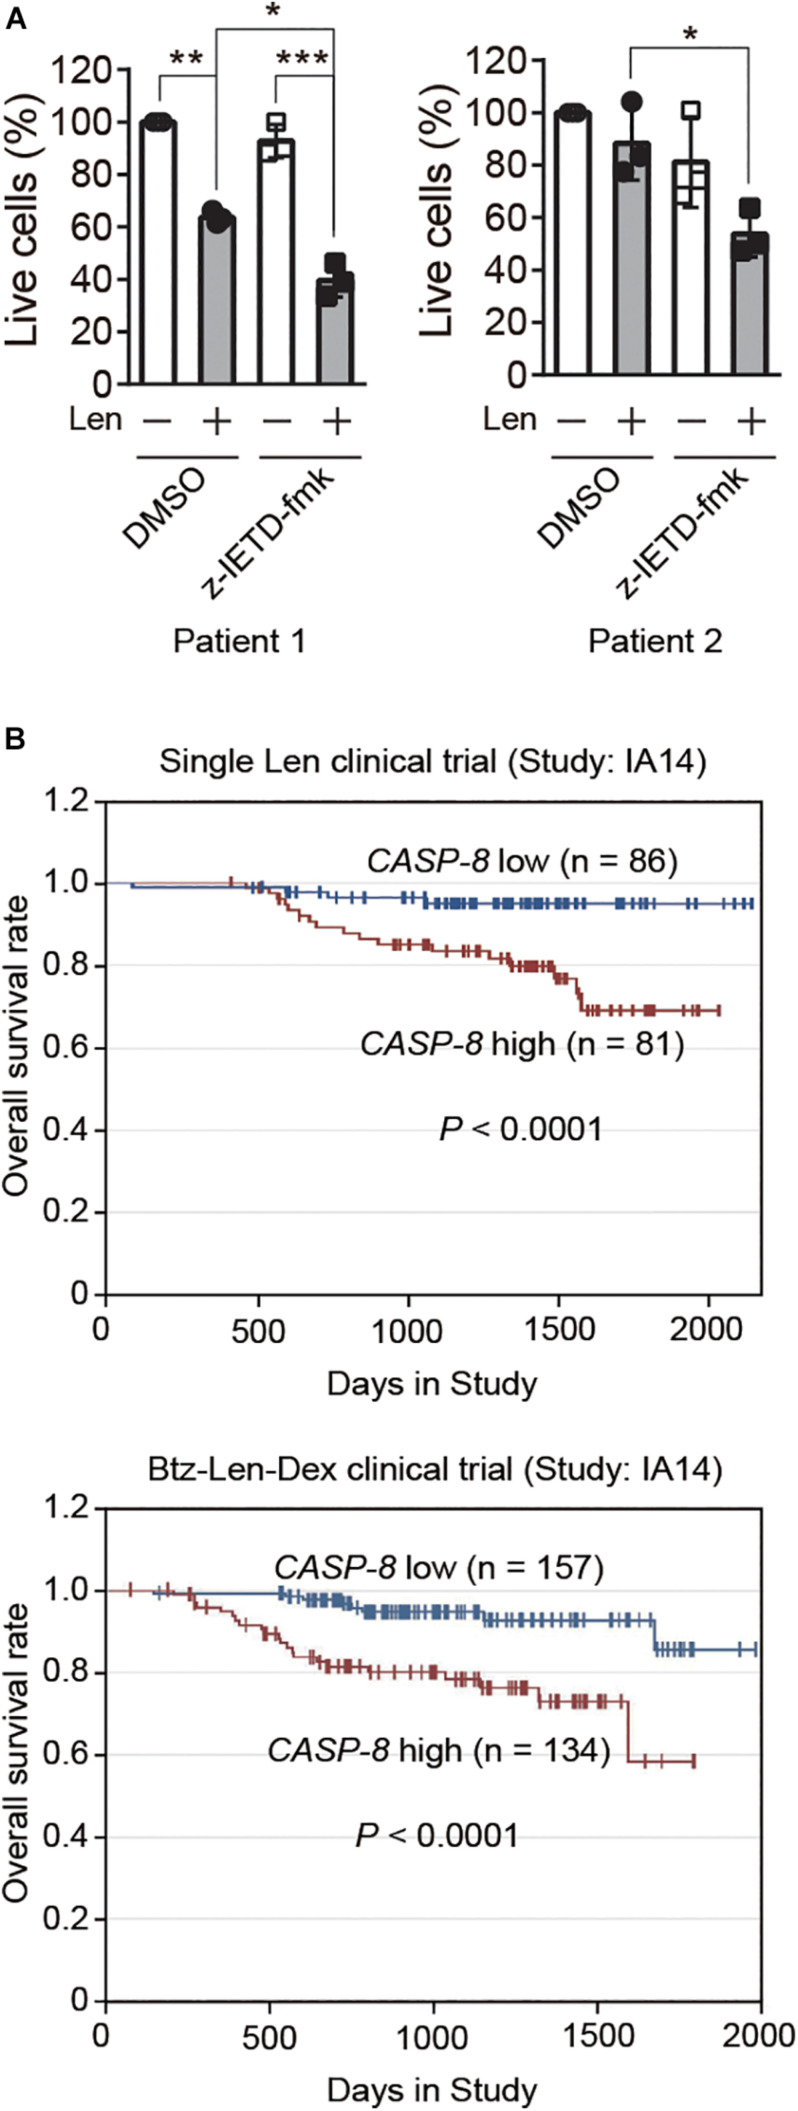
CASP-8 inhibition enhances the anti-myeloma activity of Len in primary myeloma cells, and low CASP-8 mRNA level increases the survival rate of myeloma patients. (A) CASP-8 inhibitor augments the anti-myeloma effect of Len in primary myeloma cells. CD138+ primary cells were isolated from myeloma Patient 1 and Patient 2, co-cultured with HS-5 cells, pretreated with DMSO or z-IETD-fmk (40 μM) for 1 h, and then treated with DMSO or Len (10 μM) for 4 and 5 days, respectively. The percentage of live cells was determined by staining with trypan blue and examined under the microscope. Experiments were carried out in triplicates, and pairwise Student’s t-test was used to obtain the P-value (mean ± SEMs). *P < 0.05, **P < 0.01, ***P < 0.001. (B) Low gene expression of CASP-8 increases the overall survival rate of myeloma patients. The data were obtained from patients in the MMRF CoMMpass trial (IA14) of combination therapy with Btz (Velcade), Len (Revlimid), and Dex (VRd). The numbers of patients for low (<20 FPKM) and high (>20 FPKM) CASP-8 mRNA levels were indicated in the images.